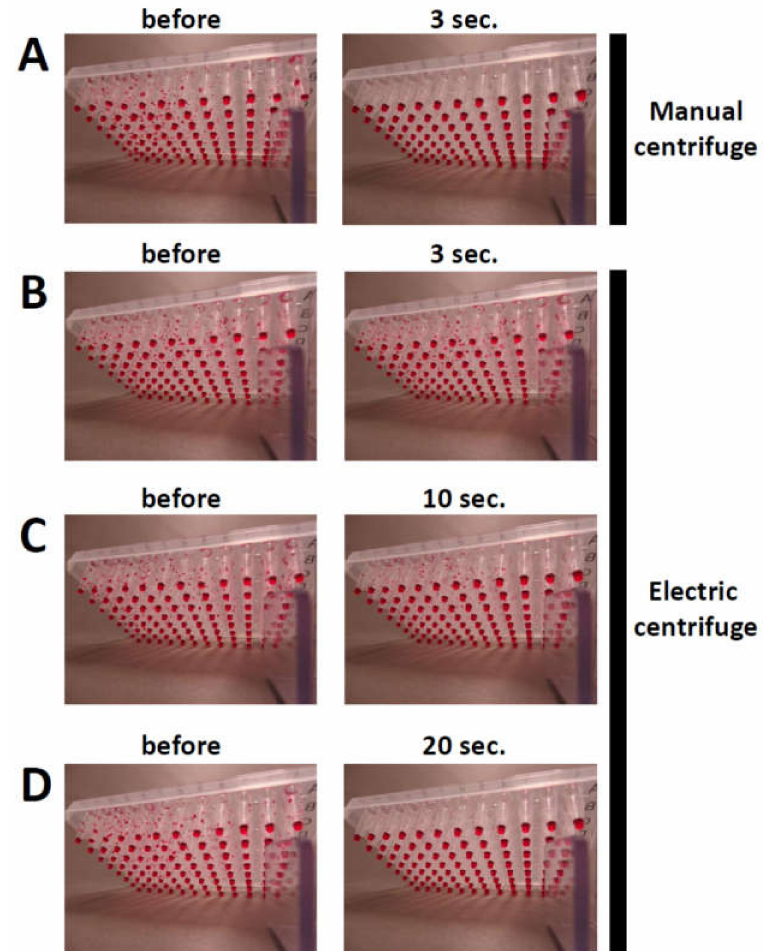
Figure 3. Centrifuged PCR solutions in 96-well PCR plates. The e ffi ciency of centrifuging the PCR solutions was evaluated before (left) and after (right) spinning. Centrifugation was performed for the indicated times (right; the times include start and stop of rotation). Manual centrifuge ( A ). Electric centrifuge ( B – D